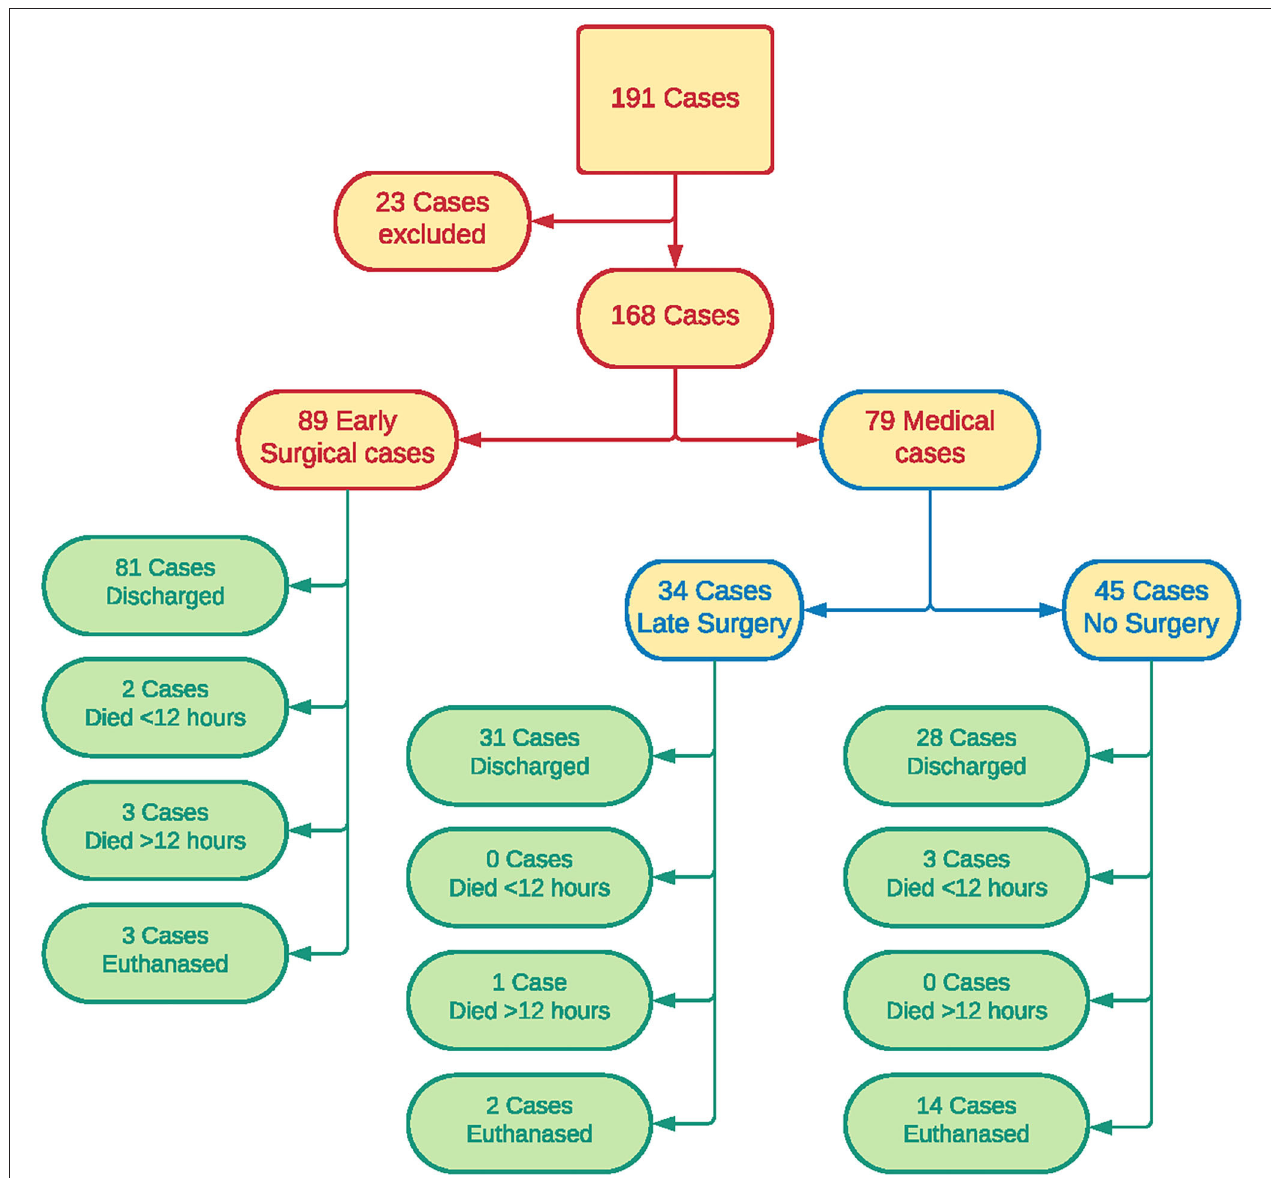
FIGURE 1 | Patient